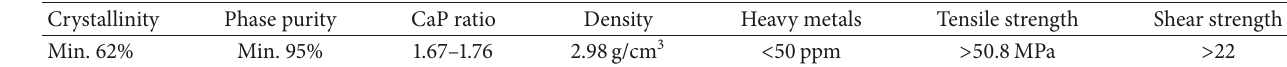
Table 4: FDA HA coating requirement [67].